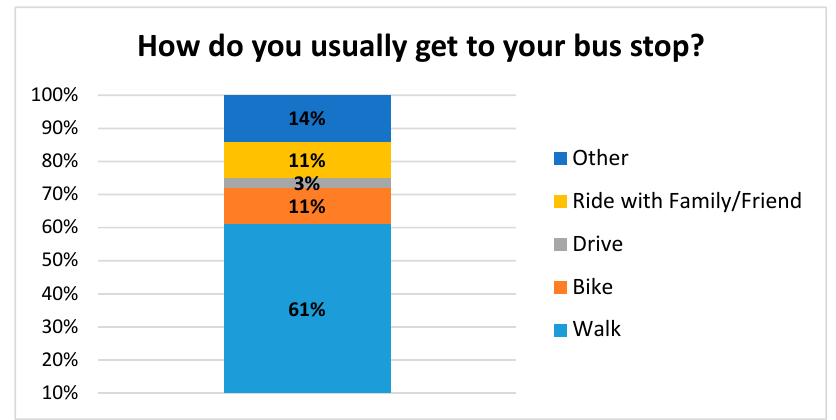
Figure 6. Perceptions about the bus service.